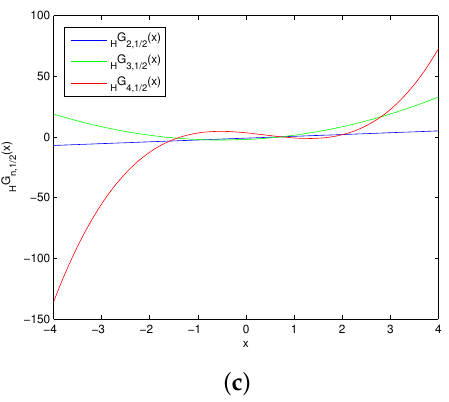
( c ) Figure 1. ( a ) Shape of H B n ,1/2 ( x ) ; ( b ) Shape of H E n ,1/2 ( x ) ; ( c ) Shape of H G n ,1/2 ( x ) .